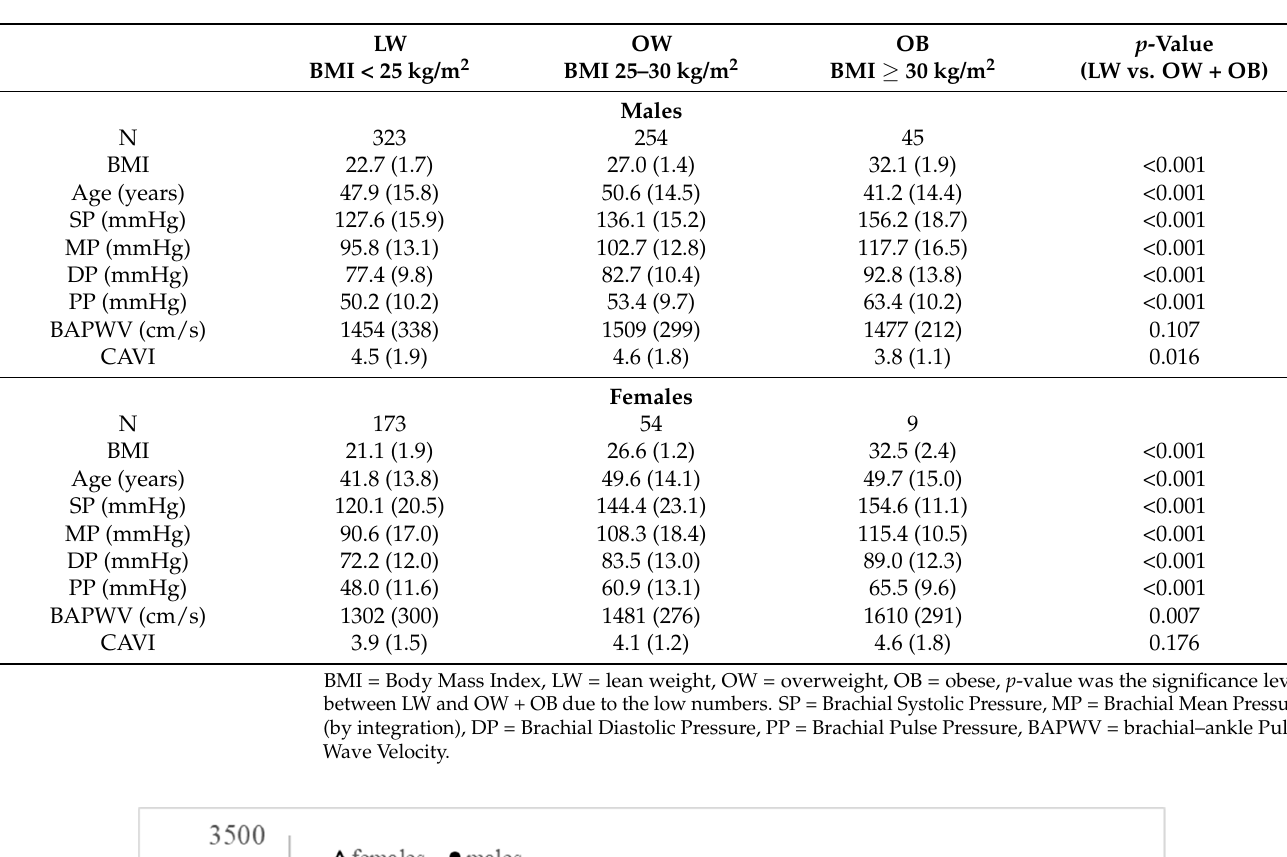
Table 3. Subjects’ characteristics according to their BMI for males (top) and females (bottom) separately.